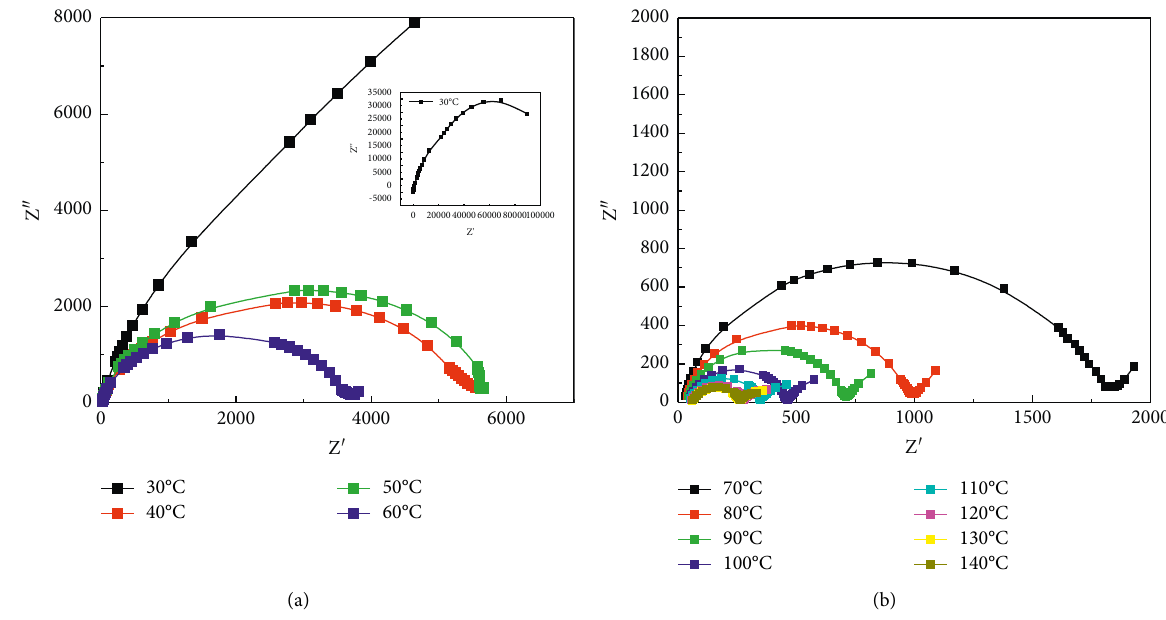
Figure 9: Complex plane plots (Z from 70 to 140 °